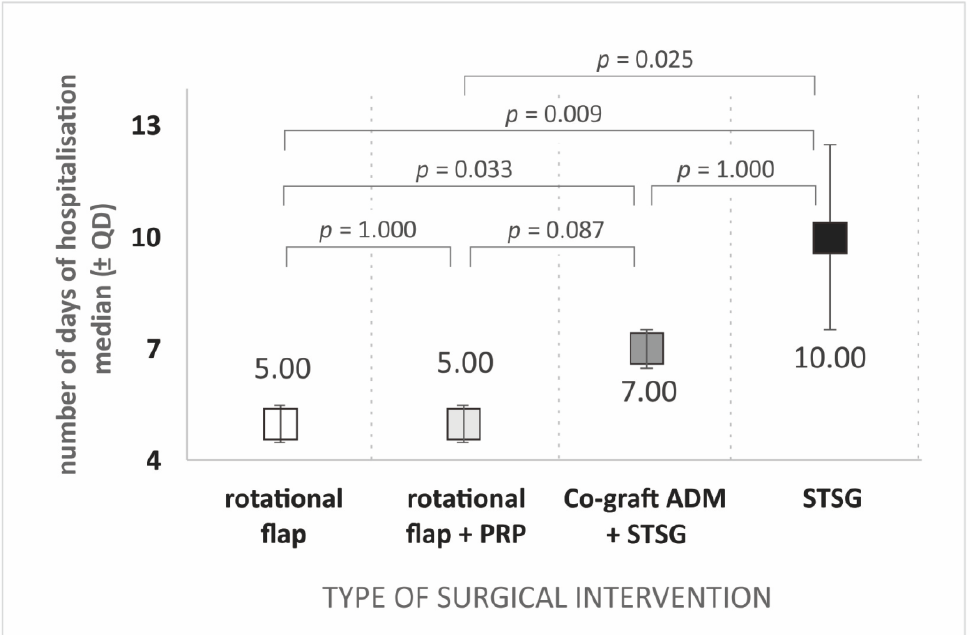
Figure 5. Duration of hospitalization depends on the type of surgical intervention. Legend: PRP, platelet-rich plasma; ADM, acellular dermal matrix; STSG, split-thickness skin graft.